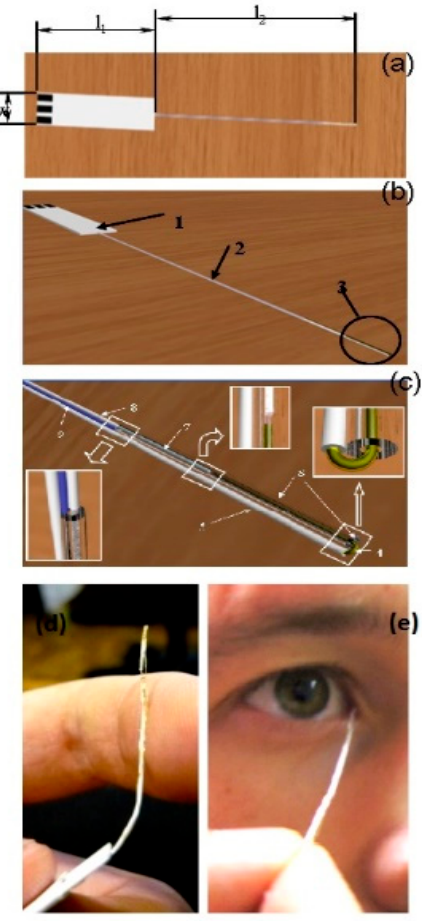
Figure 3. Schematic view of the flexible non-invasive micro-biosensor. ( a ) l1—length of a handle (from 10 mm up to 50 mm, optimum 20–30 mm), l2—length of a flexible sampling part (from 40 mm up to 100 mm, optimum is 50–60 mm), w—width of the handle (from 5 mm up to 10 mm). ( b ) 1—the handle with three electrical contacts, 2—the flexible sampling part (total diameter from 0.05 mm up to 0.5 mm), 3—the flexible part of the device with a microcell. ( c ) Flexible part of the sapling device including a microcell. 4—working electrode (diameter from 0.01 mm up to 0.2), 5—insulated part of the working electrode, 6—polymeric tube (internal diameter from 0.015 mm up to 0.25), external diameter from 0.02 mm up to 0.4, length from 1 up to 40 mm) fused to the insulated part of the working electrode, 7—counter and reference electrode (diameter from 0.01 mm up to 0.2 mm), 8—insulated part of counter and reference electrode, 9—checking / control electrode (diameter from 0.01 up to 0.2 mm). Distance between ends of working and opposite electrodes from 0.01 mm up to 1 mm. ( d ) Photograph demonstrating the flexibility of the biodevice. ( e ) Photograph of authentic sampling. Reproduced from [47] with permission from Springer.